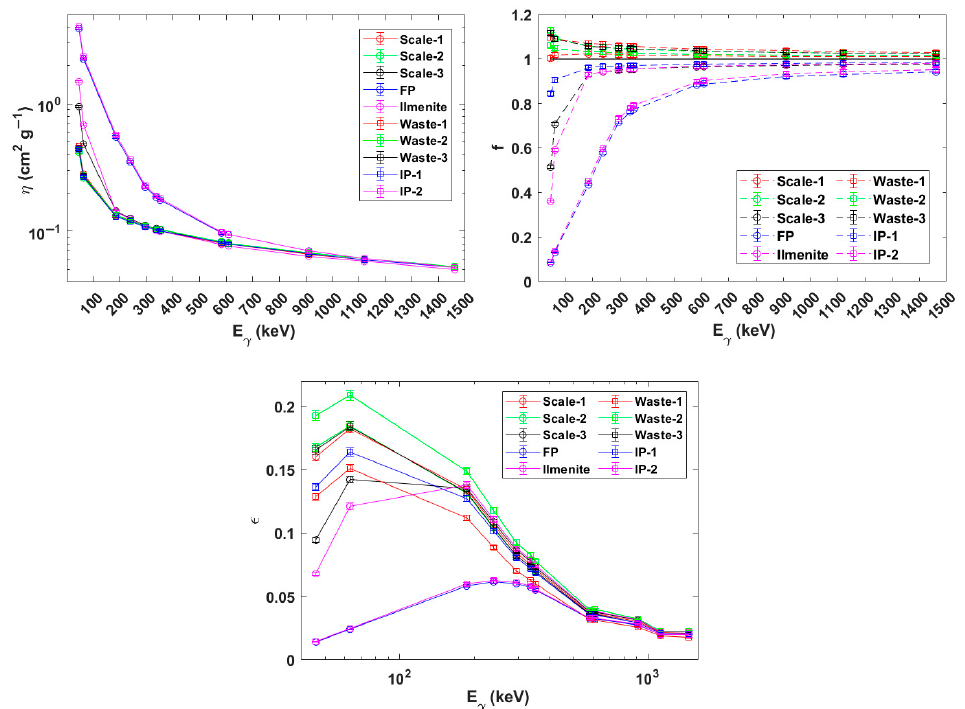
Figure 2. Obtention of the mass attenuation coefficient, η , at each energy of interest ( E γ ) for several sample matrices selected in this study, which were scale samples (from Scale-1 to Scale-3), a final product (FP), an ilmenite (Ilmenite), wastes (from Waste-1 to Waste-3), and intermediate products (IP-1 and IP-2). The self-attenuation correction factor, f , is shown versus E γ for each chosen sample, allowing us to calculate the detector efficiency for each problem sample, ε . Table 2. Chemical compositions (each chemical element, Z i , given in %) and apparent densities ( ρ , in g · cm − 3 ) of the mining samples analyzed in this